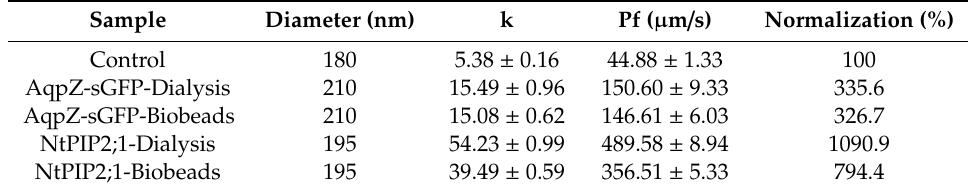
Table 1. Water permeability from di ff erent samples. Figure 3. Water permeability of AqpZ-sGFP and Nt PIP2;1 proteo-liposome reformed via a detergent re-solubilization of the L-CFPS produced sample. A and B , normalized and averaged light scattering measurements of AqpZ-sGFP and Nt PIP2;1 proteo-liposome under osmotic shock via a stopped-flow spectrophotometry ( n = 8–10). Red trace, proteo-liposome formed via the step dialysis method; blue trace, proteo-liposome formed via bio-beads; black trace, control empty liposomes. C , bar chart of the calculated water permeability P f (mean ± SD) of corresponding samples.